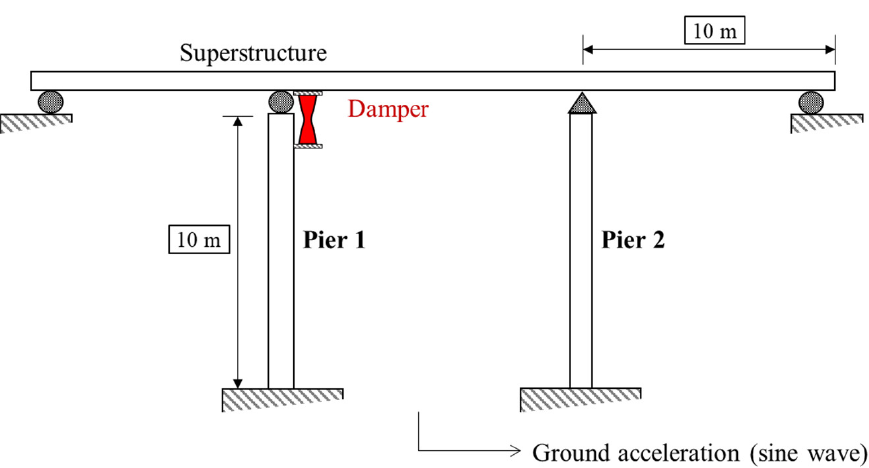
Figure 9. Prototype bridge dimensions and boundary conditions.